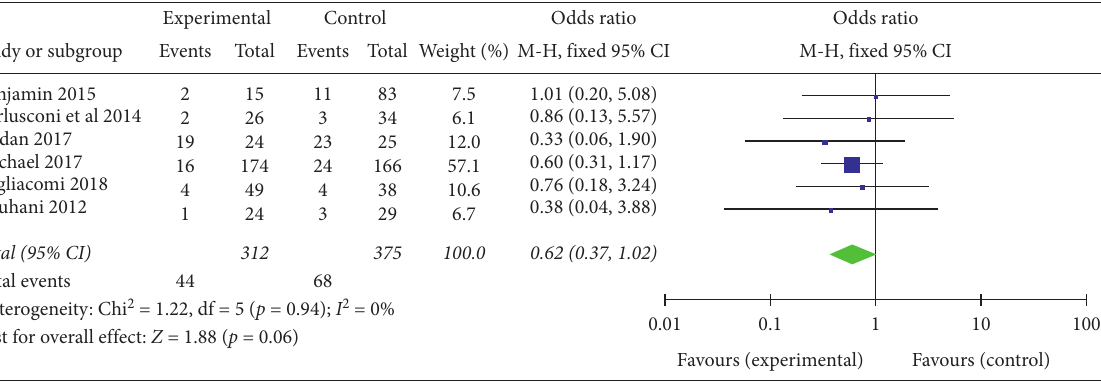
Figure 2: Nonunion rate at 6 months after surgery.